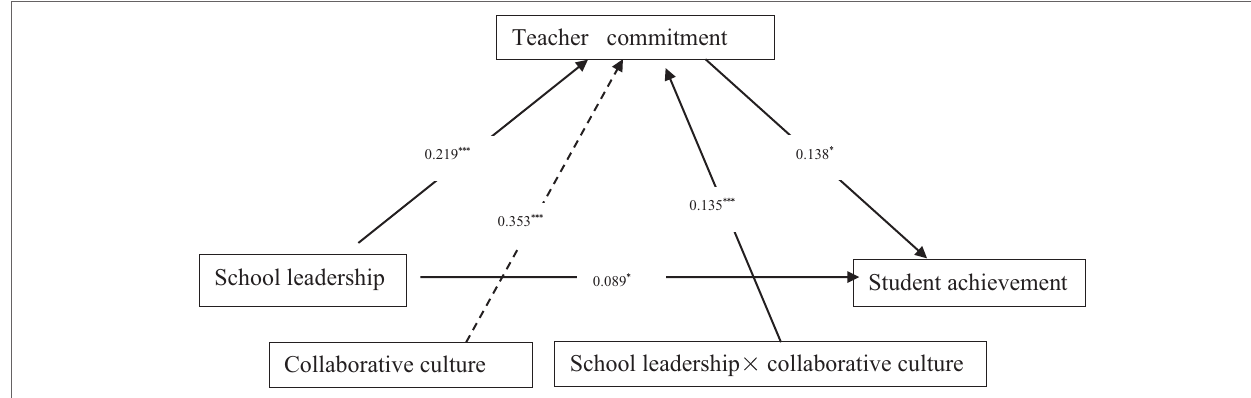
FIGURE 2 | Confirmed moderated mediation model linking SL, TC, CC, and SA. *p < 0.05; ***p < 0.001